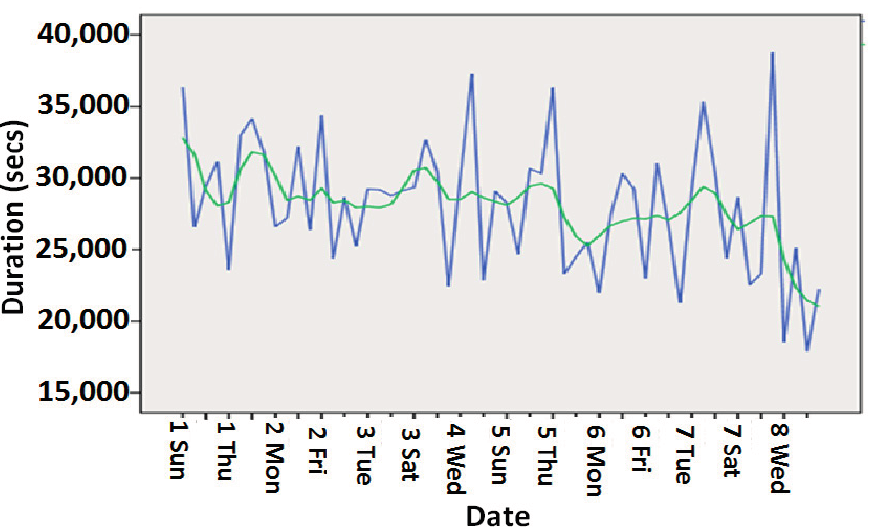
Figure 9. Bed usage durations and